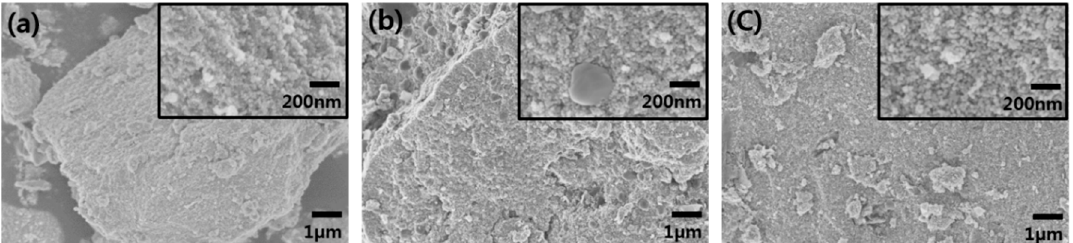
Figure 3. Scanning electron microscopy (SEM) images of ( a ) ZFO, ( b ) ZFO–G, and ( c ) ZFO–G–GL.